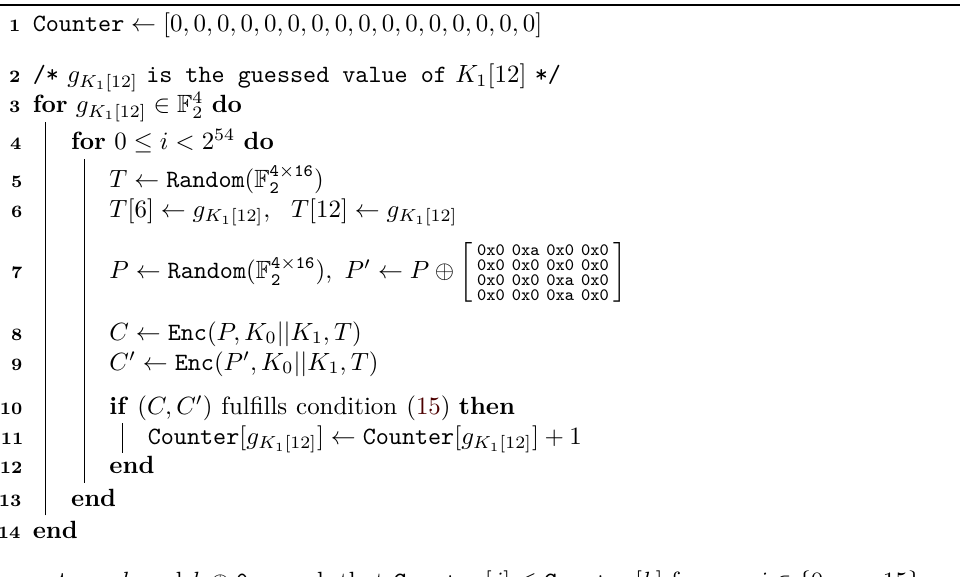
must be of the form given by ∆ w 0 15 ⊕ x 15